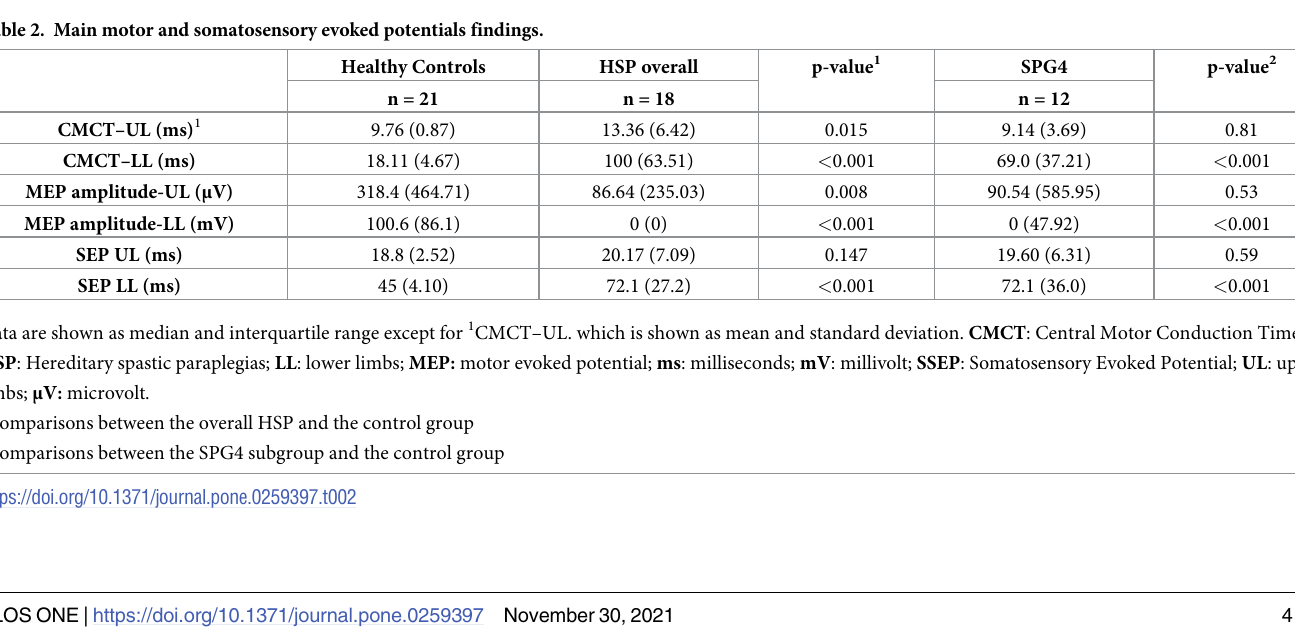
Data are shown as mean and standard deviation. HSP : Hereditary spastic paraplegias; ns , not statistically significant; SPRS: Spastic Paraplegia Rating Scale; mSPRS: Motor Spastic Paraplegia Rating Scale. 1